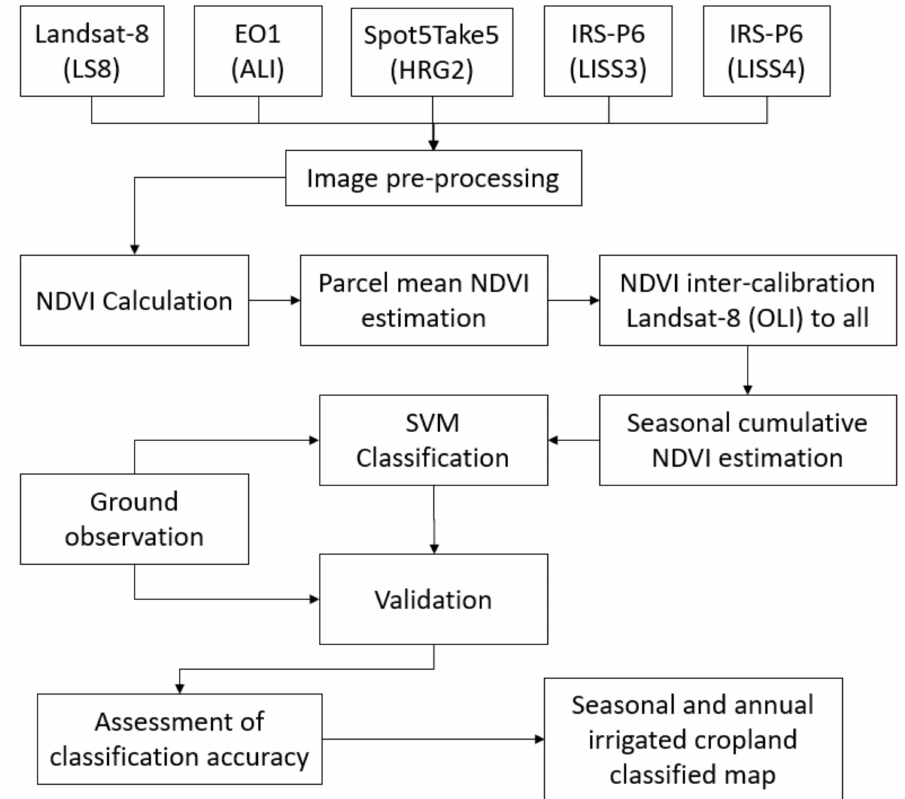
Figure 5. Flowchart of the developed method. Abbreviations used in the figure are as follows: EO1, Earth Observing-1; ALI, Advanced Land Imager; IRS-P6, Indian Remote-Sensing Satellite-P6 also known as ResourceSat-1; LISS3, Linear Imaging Self Scanning Sensor-3; LISS4, Linear Imaging Self Scanning Sensor-4; OLI, Operational Land Imager; HRG-2, High Resolution Geometric-2; SVM, Support Vector Machine; NDVI, Normalized Differential Vegetation